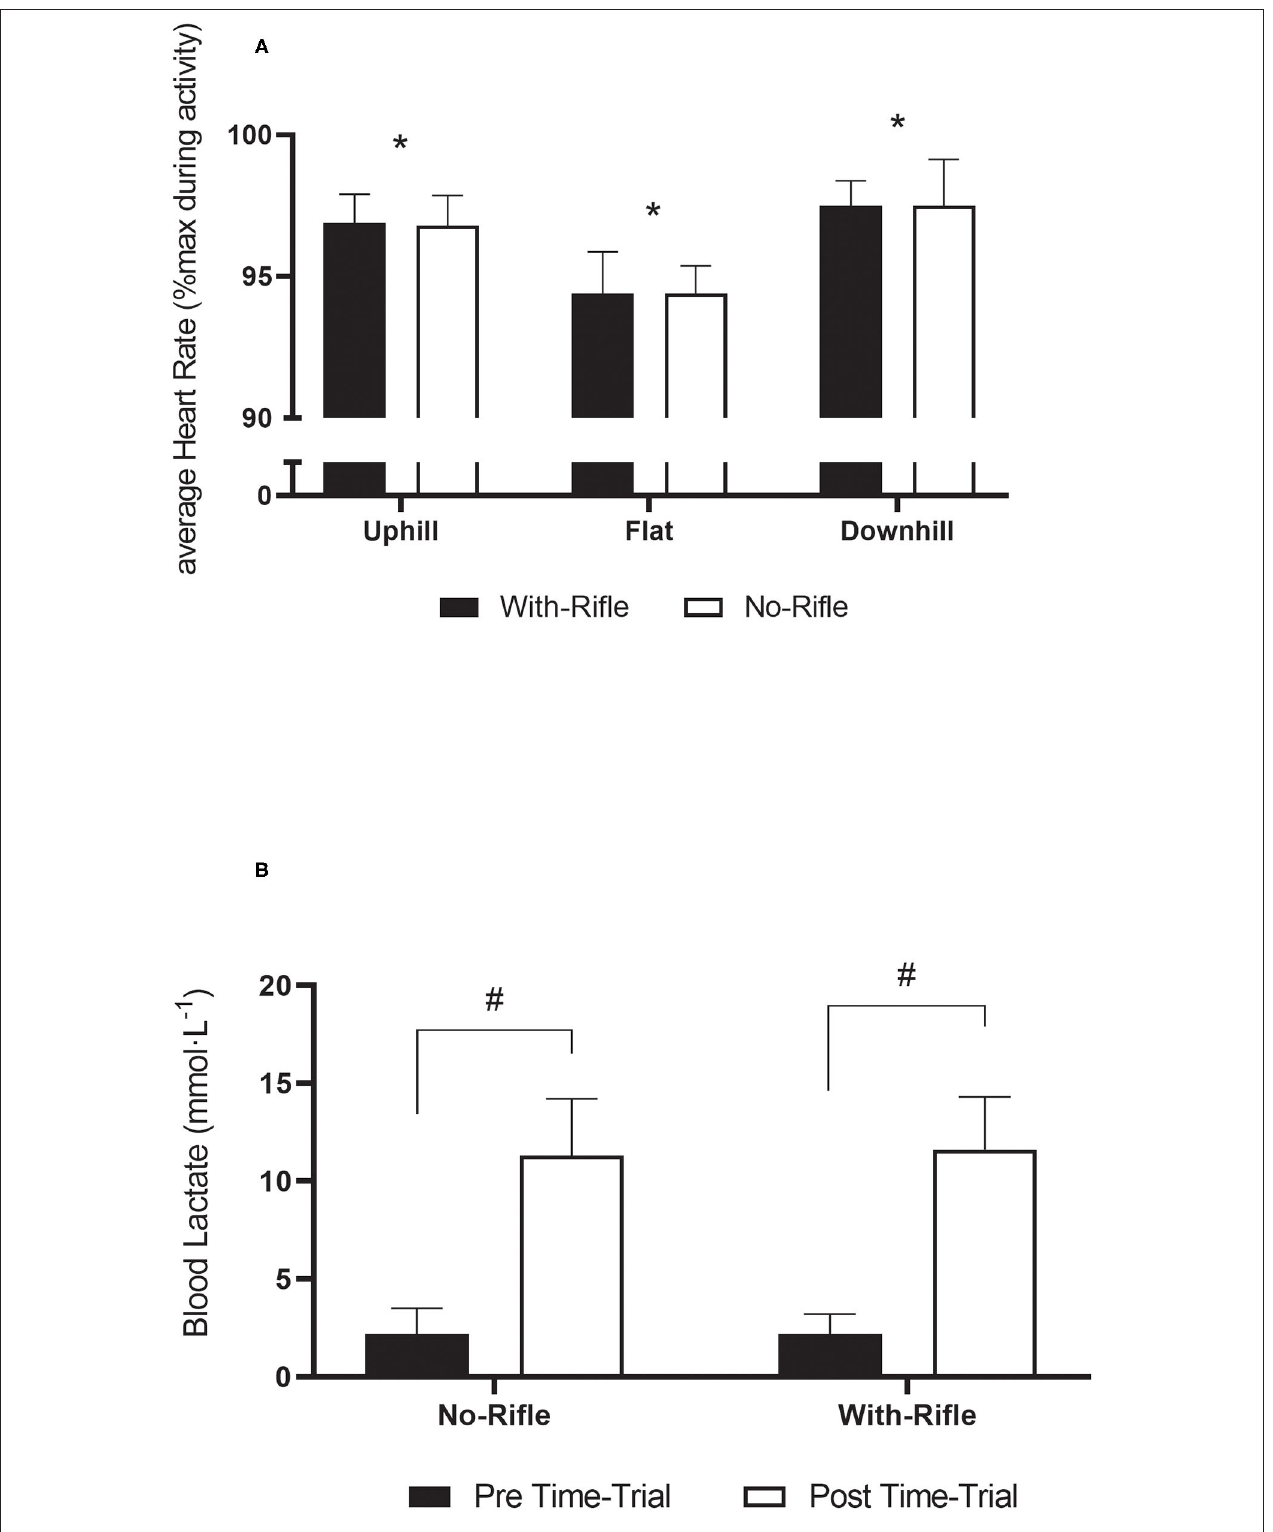
FIGURE 3 | Heart rate (A) and blood lactate (B) responses to the time-trials. Mean ± standard deviation. *Indicates different to With-Rifle ( p < 0.001); # indicates different to pre time-trial ( p < 0.001).